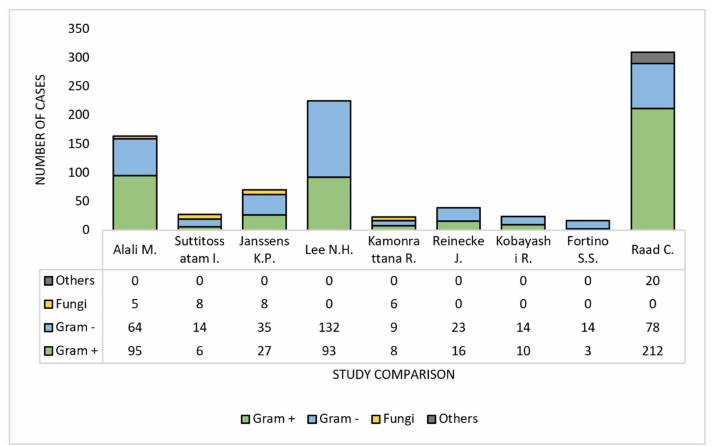
Figure 3. Individual look upon the pathogens involved in the MDIs: Alali M. et al. (2020) [13]; Suttitossatam I. et